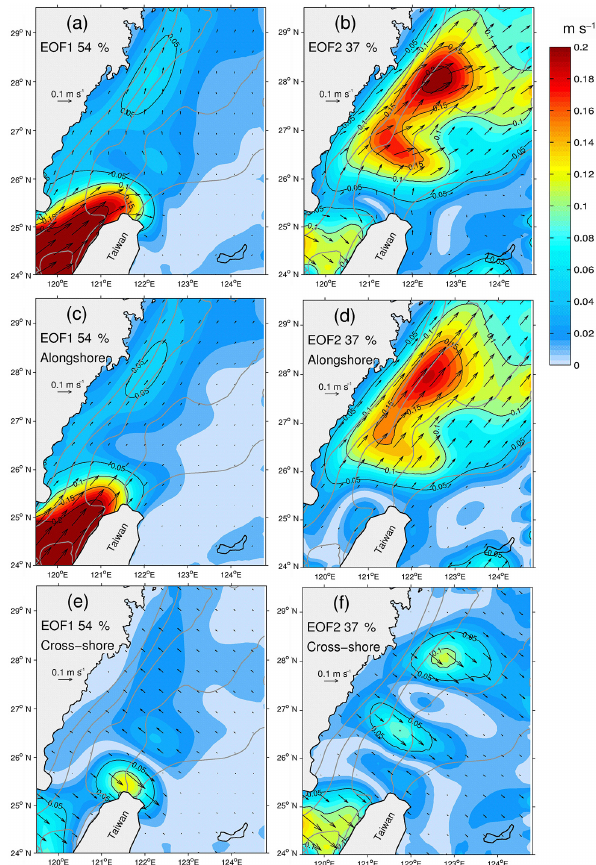
Figure 9. The spatial pattern of the first (EOF1; left panels) and sec- ond (EOF2; right panels) leading modes of the VMV in the ECS: (a) EOF1 currents, (b) EOF2 currents, (c) EOF1 alongshore compo- nent, (d) EOF2 alongshore component, (e) EOF1 cross-shore com- ponent and (f) EOF2 cross-shore component (all shown by black arrows with the color representing the magnitude). The 30, 50, 70, 100 and 200m isobaths are indicated with gray